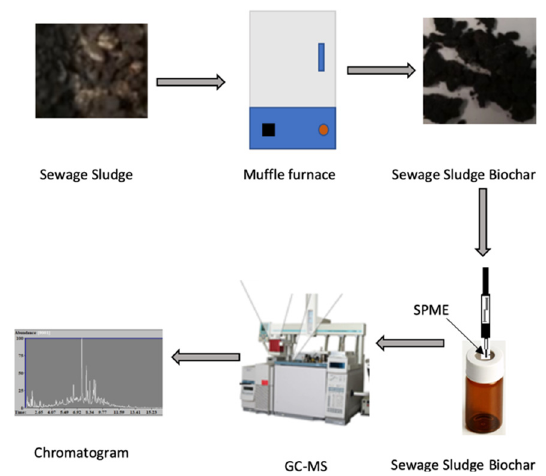
Figure 3. The experimental procedure.